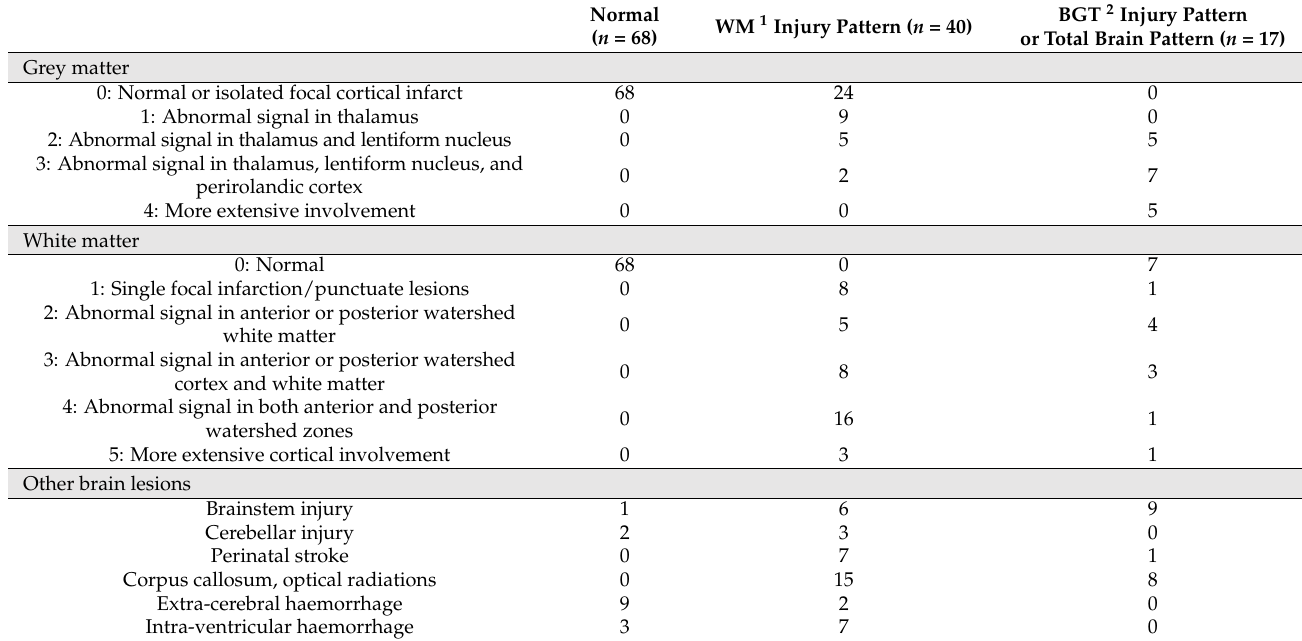
1 WM: White matter, 2 BGT: Basal ganglia-thalamus.